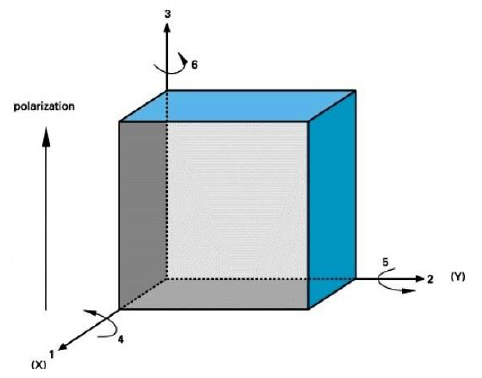
Figure 4. Poled piezoelectric ceramic [50].